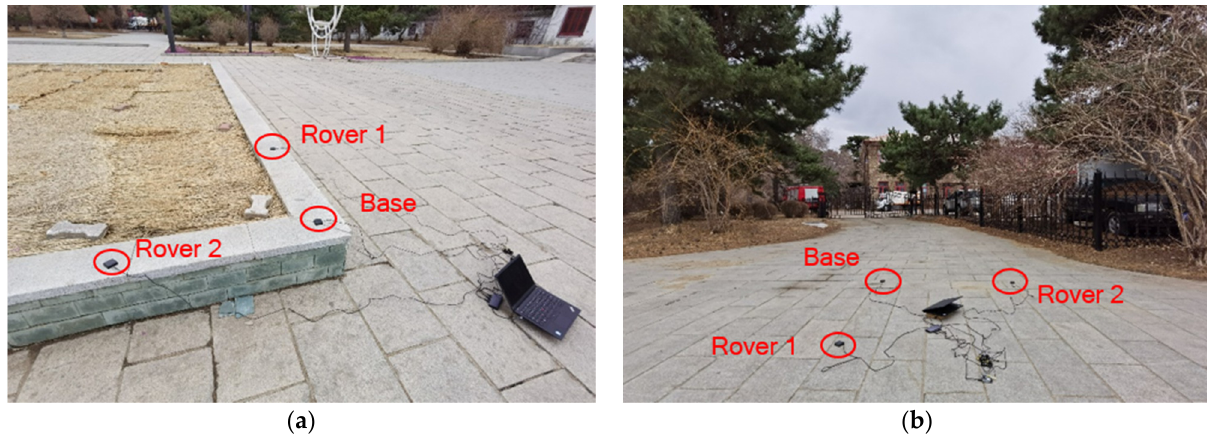
Figure 3. Open-sky ( a ) and degraded ( b ) observation environments, recorded with Ublox M8T, patch antenna on 8 March 2020.